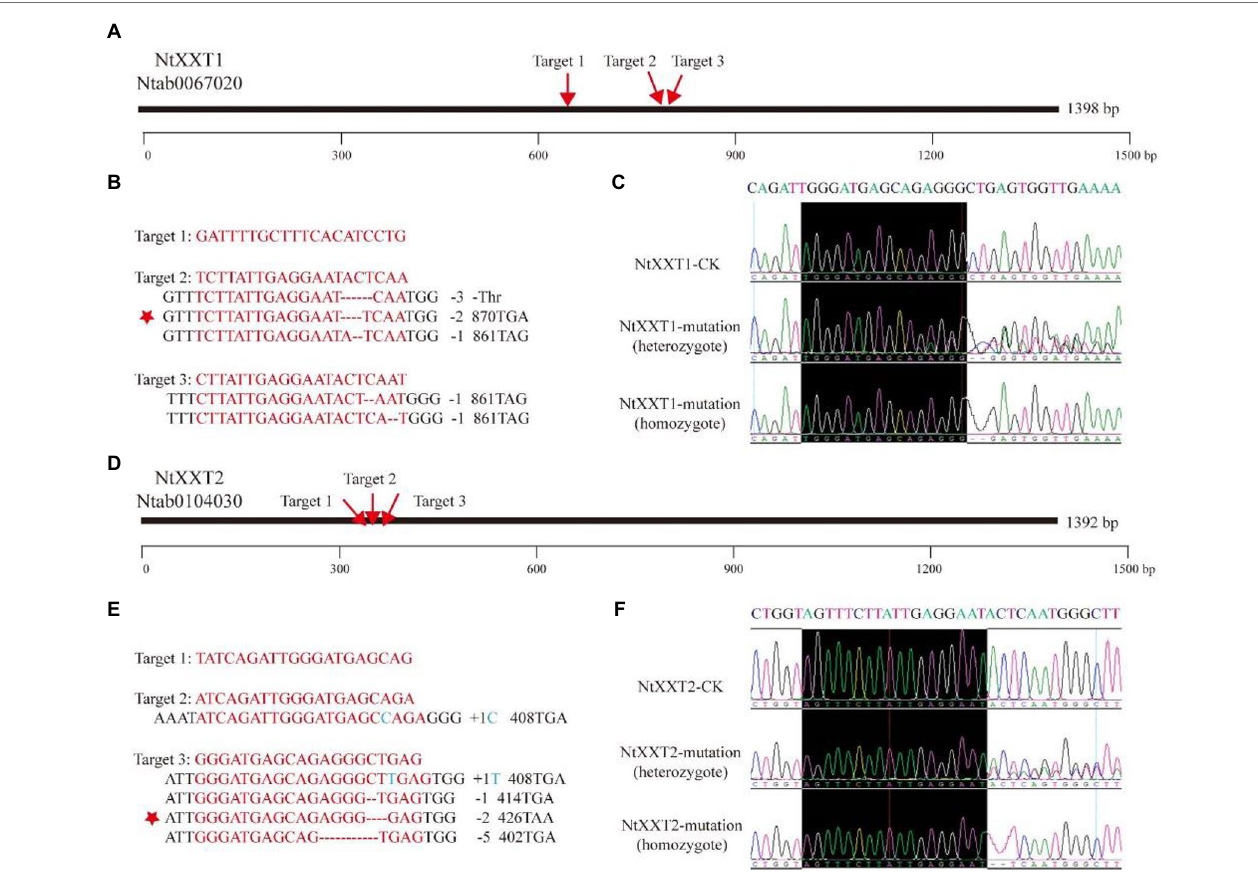
FIGURE 2 | Regions of NtXXT1 and NtXXT2 targeted by CRISPR-Cas9. (A) The gRNA targets in the NtXXT1 . The red arrows indicate the positions of the three target sites. (B) Editing profiles at NtXXT1 . The target sequence is shown in red letters, for which red dashes indicated deletions. Different editing types were detected which can result in amino acid deletion and termination codon. The red stars indicated the deletion lines which were obtained homozygous lines and used for further analysis. (C) The knockout of NtXXT1 was verified by gold-standard Sanger sequencing in heterozygous and homozygous lines which comes from the red star labeling in (B) . The black box indicated the target sequence upstream of the editing location. (D) The gRNA targets in the NtXXT2 . The red arrows indicate the positions of the three target sites. (E) Editing profiles at NtXXT2 . The target sequence is shown in red letters, for which red dashes indicated deletions, and the blue letters indicated insertion. Different editing types were detected which can result in termination codon. The red stars indicated the deletion lines which were obtained homozygous lines and used for further analysis. (F) The knockout of NtXXT2 was verified by gold-standard Sanger sequencing in heterozygous and homozygous lines. The black box indicated the target sequence upstream of the editing